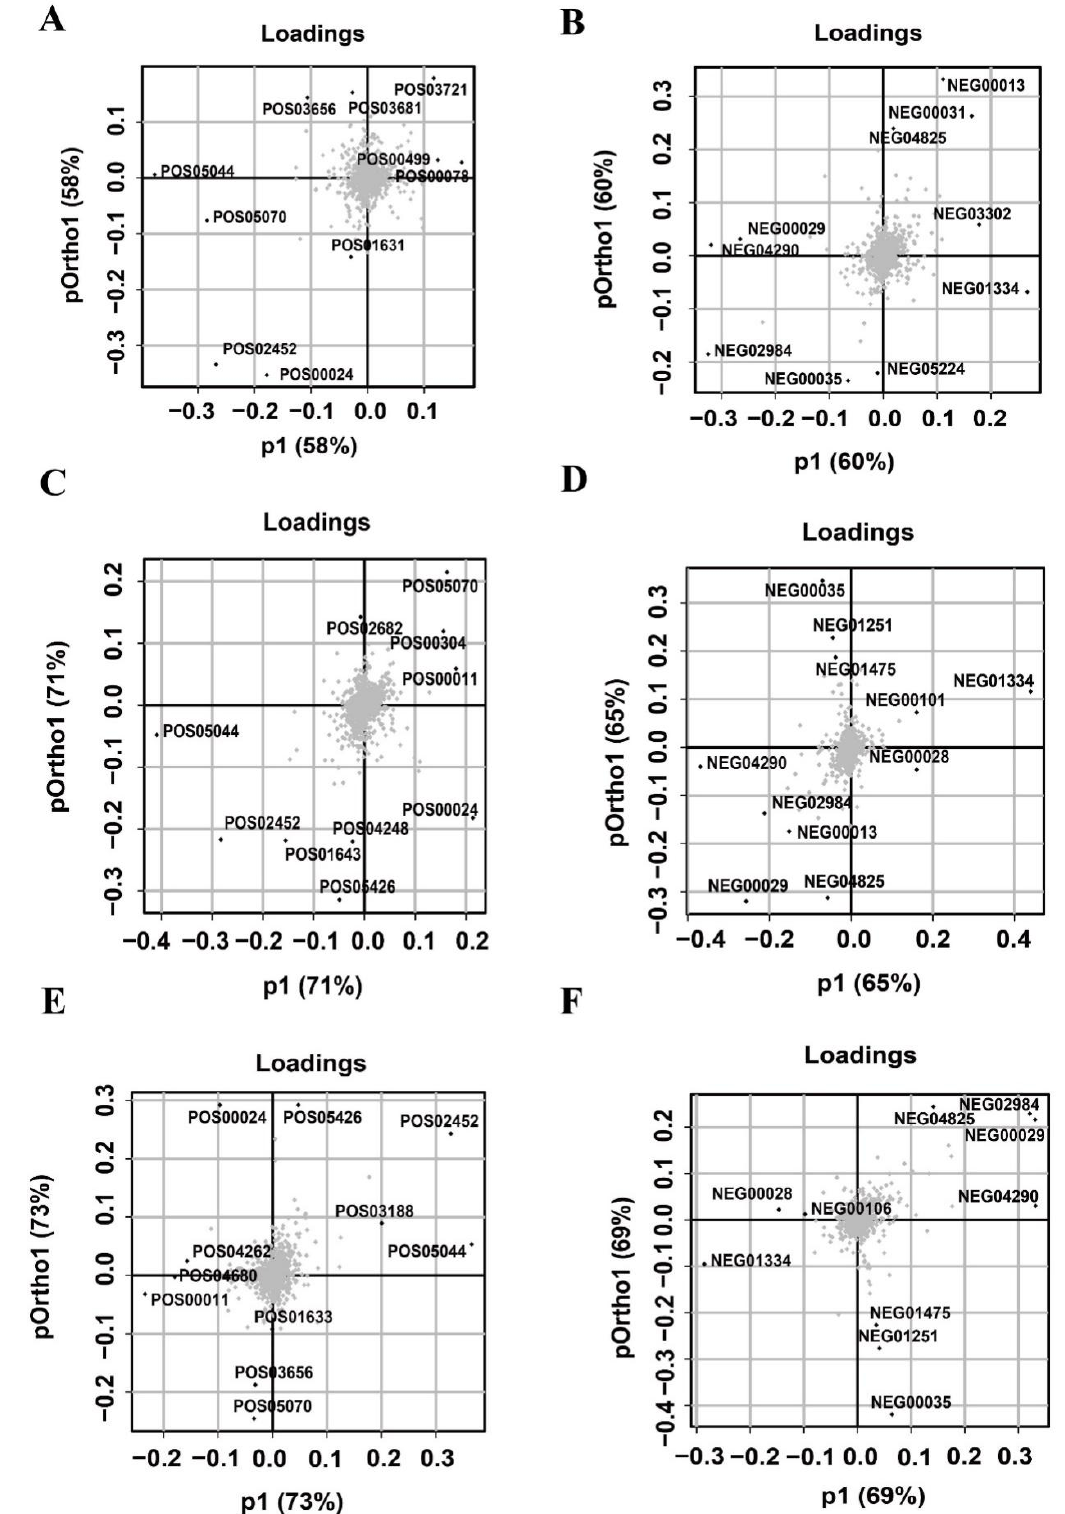
Figure 4. Screening of metabolites with high contribution to the differentiation of groups using the loading plot. Important variables that distinguish chicken and duck meat in positive ion ( A ) and negative ion ( B ) modes. Important variables that distinguish chicken and pork in positive ion ( C ) and negative ion ( D ) modes. Important variables that distinguish chicken and beef in positive ion ( E ) and negative ion ( F ) modes.